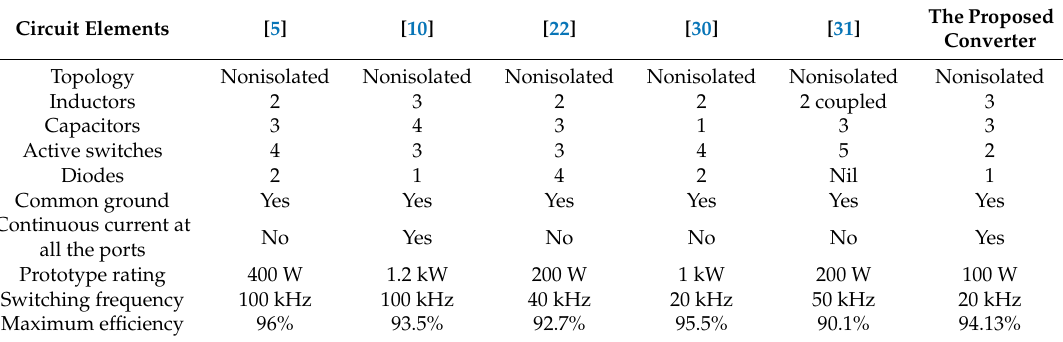
Figure 19. Maximum efficiency for various modes. Table 3. Comparison of